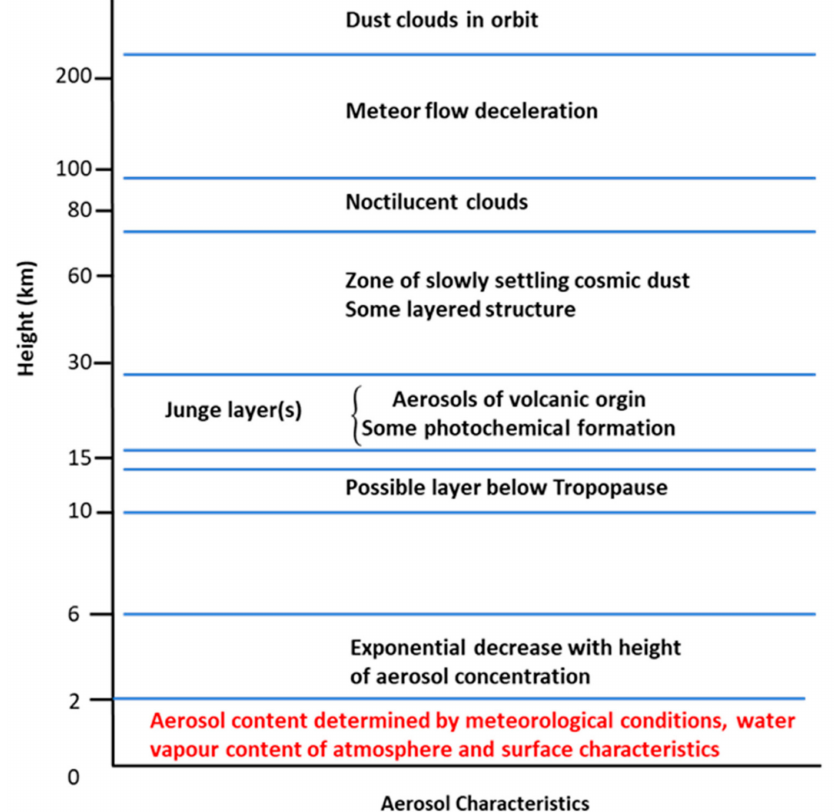
Figure 5. Atmosphere aerosol vertical profile. Adapted from